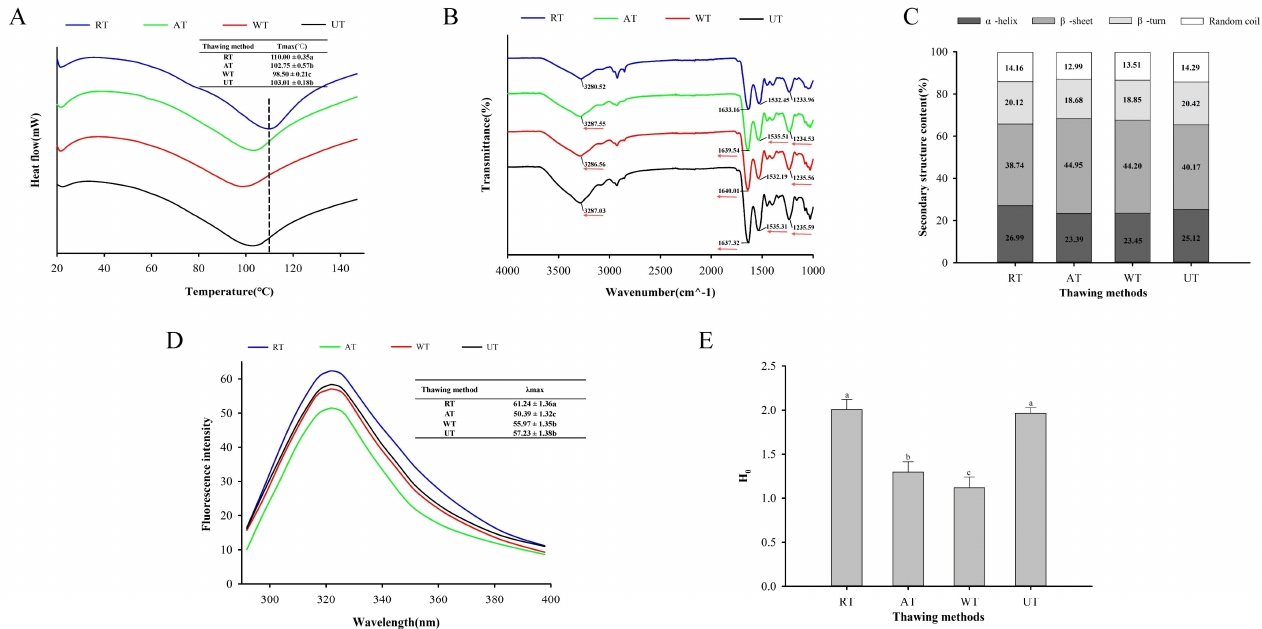
Figure 4. Influence of different thawing methods on the differential scanning calorimetry (DSC) ( A ), fourier transform infrared radiation (FTIR) ( B ), protein secondary structure ( C ), fluorescence spectroscopy ( D ), and surface hydrophobicity ( E ) characteristics of frozen instant sea cucumber. Values of different groups with different lowercase letters (a–c) are significantly different at p < 0.05.